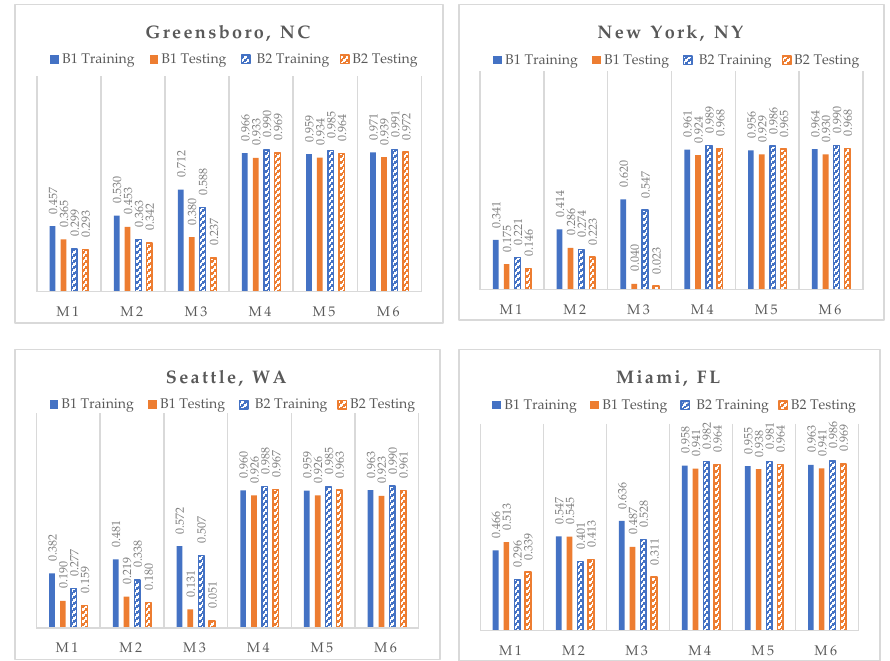
Figure 7. Correlation coefficient values for training and testing data sets of six models in four different locations for Buildings 1 and 2.